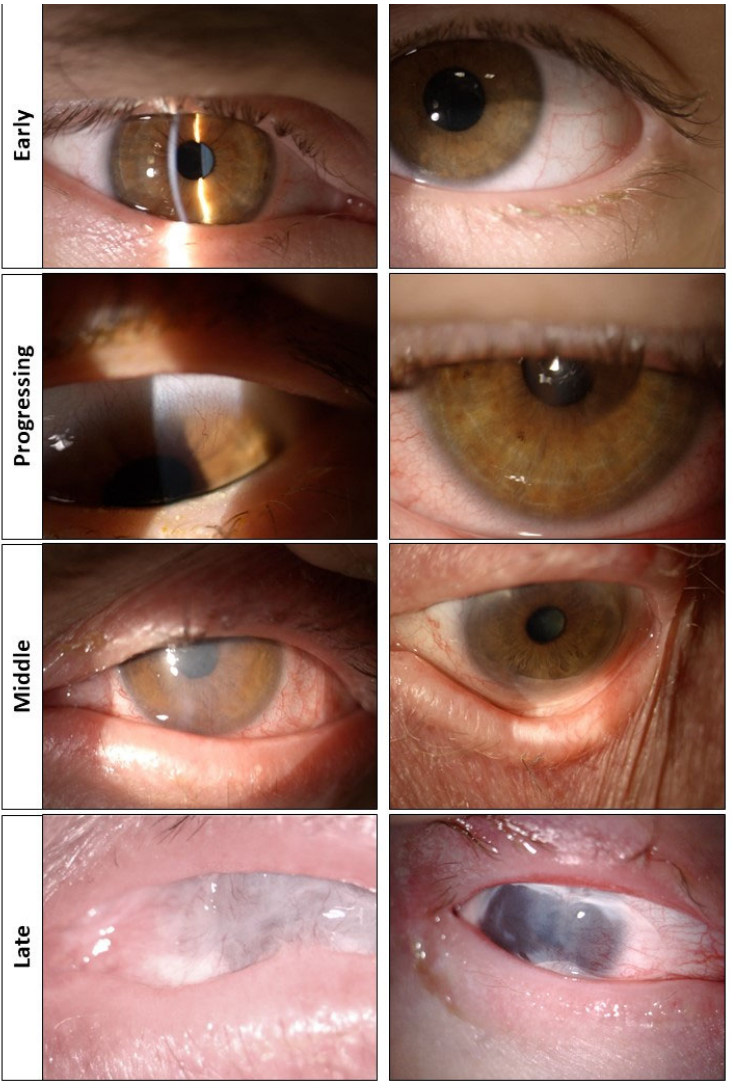
Figure 2. Ocular phenotype in patients with Ectrodactily-Ectodermal dysplasia Clefting (EEC) syndrome and stages of the pathology. No signs of corneal pannus or inflammatory infiltrates are present in the cornea, which still appears transparent (early stage). Traces of corneal hyperemia and neovascularizazion are starting to be visible, with vessels beginning to invade the cornea. The palisades of Vogt are almost absent (progressing stage). The corneal pannus invades the cornea with neovascularization progressing from both sides of the eye. The palisades of Vogt are absent (middle stage). Keratopathy with dense vascularized corneal pannus and symblepharon of the internal cantus are present. The palisades of Vogt are completely absent (late